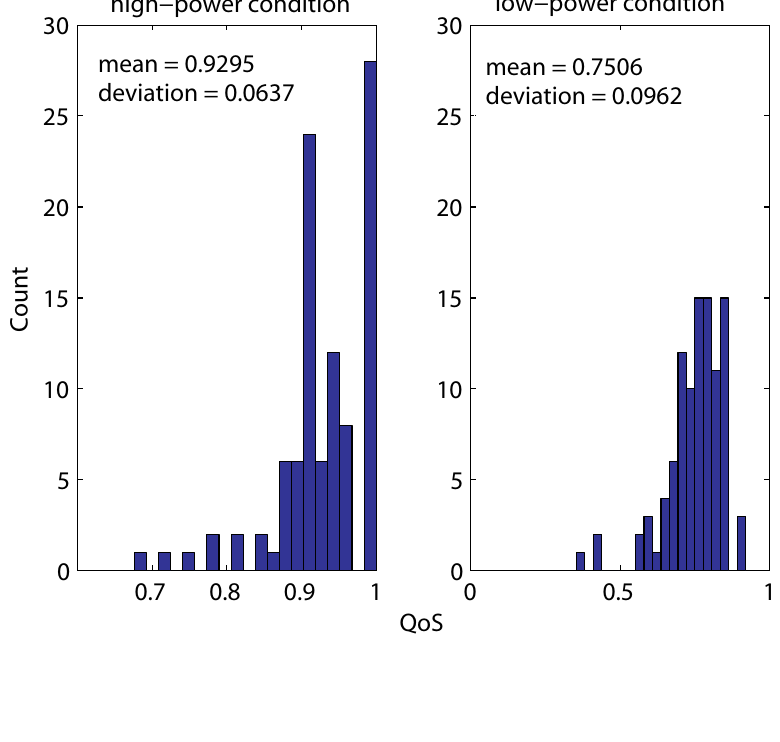
Figure 18. Histogram of the QoS performance under the response-time-oriented policy for ( left ) high and ( right ) low power storage